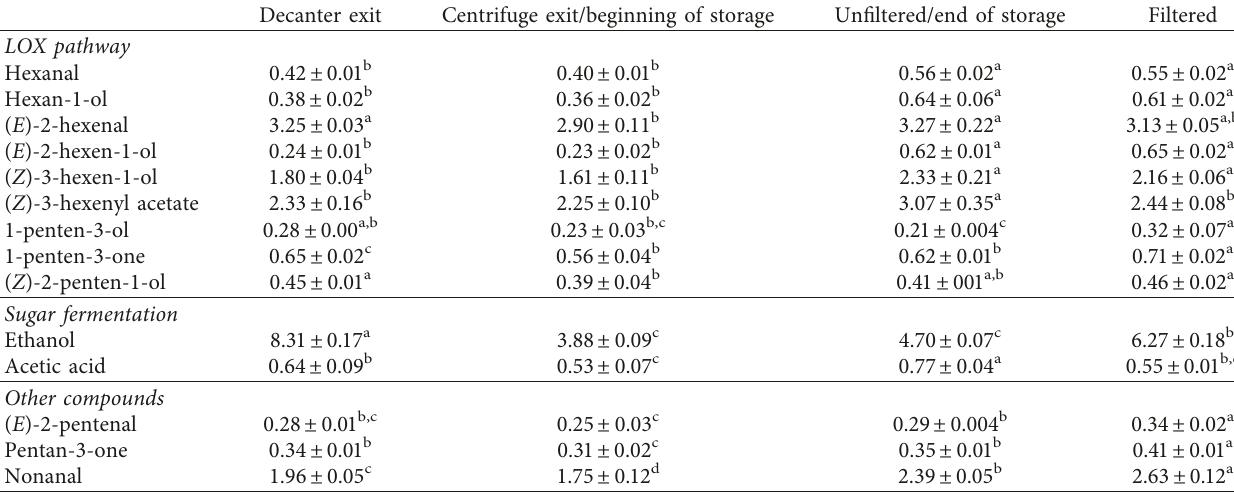
∗ Values are expressed as mean ± SD; (a, b, c, d) indicate Fisher’s least significant differences (LSD), with statistically significant differences at 95% confidence level. Table 2: Individual content of volatile compounds before and after vertical centrifugation, storage, and filtration processes, expressed in mg/ kg